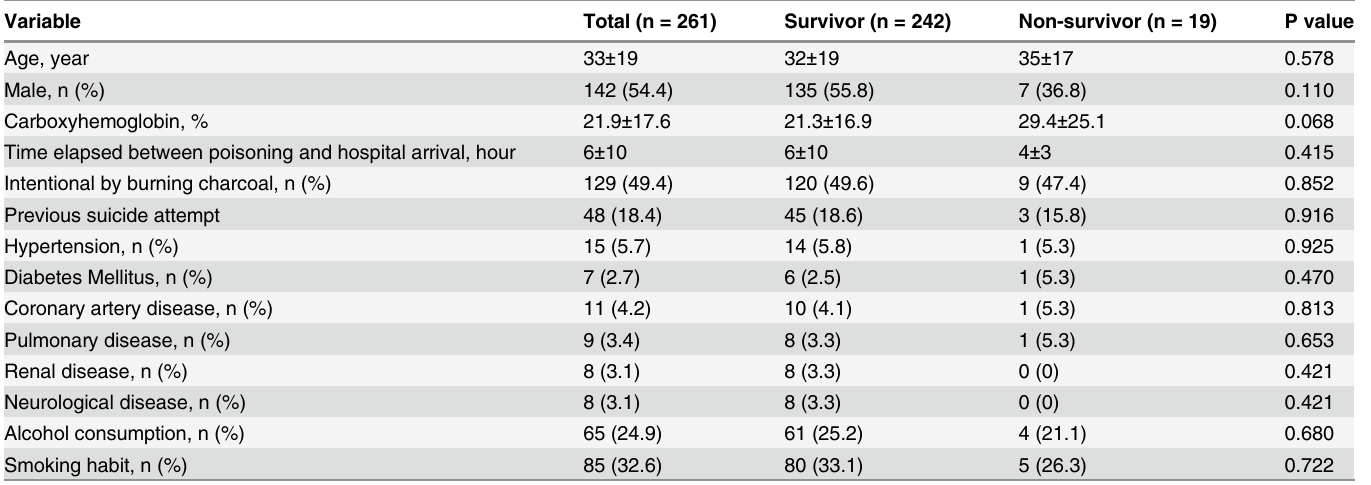
Table 1. Baseline characteristics of patients with CO poisoning, strati fi ed according to status at discharge as alive (survivors) or dead (non- survivors). Variable